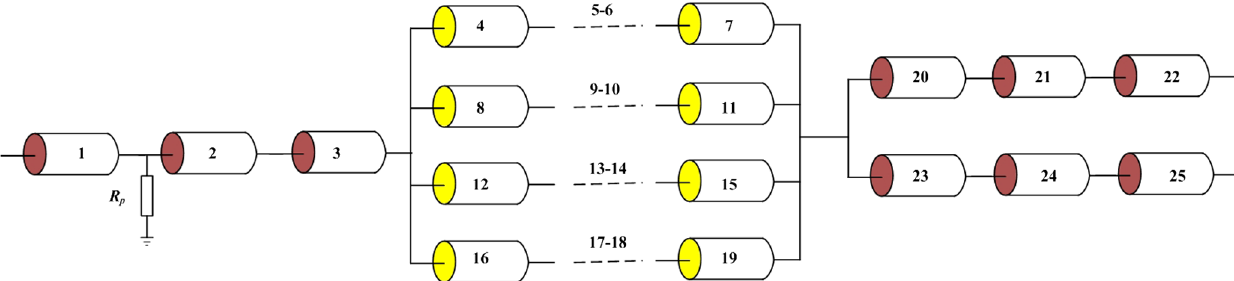
FIG. 12. Subcircuit of the water convolute in Fig. 3. The power from two adjacent modules merges after TL2 and is then transmitted downstream by a vertical triplate line (line 1 to 3). In the middle, the four levels represent the gradual transition from vertical to horizontal. When the transition is completed, two paralleled horizontal triplate lines connect to the insulation stack. Line 22 connects to levels A and B, and line 25 connects to levels C and D, of the insulation stack.